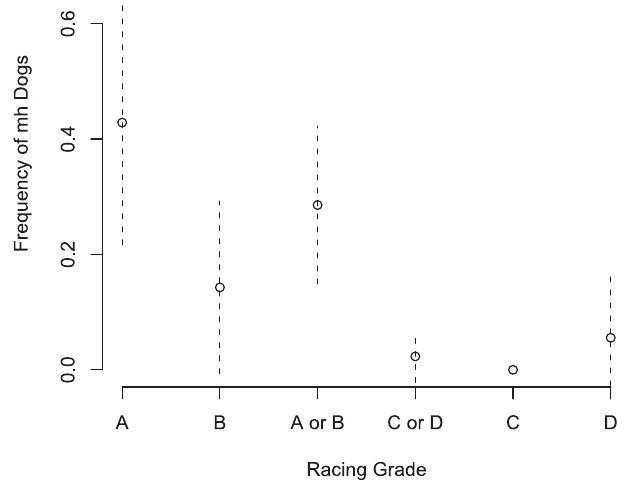
Figure 4. Frequency of Whippets Carrying the Mutation among the Dogs Sampled in Each Racing Grade Dotted lines above and below each point represent 95% confidence intervals on the frequency ( 6 1.96 standard error on the